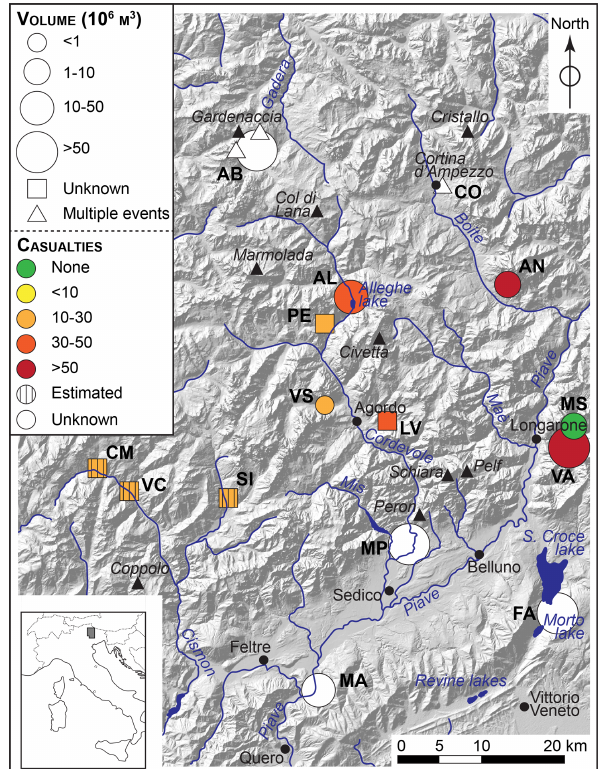
Figure 8. Largest and most damaging (in terms of human lives) landslides located near Mt. Peron (base map is a SRTM- derived digital elevation model with 30m cells; source: http: //viewfinderpanoramas.org/, last access: 17 October 2019). Vol- umes of deposits correspond to the size of the symbols; casu- alties are shown with colour coding. AB: Alta Badia, several events between 11500BCE and present (Borgatti et al., 2004); AL: Alleghe, 1771CE (Ermini and Casagli, 2003); AN: Antelao, 1814CE (Montandon, 1933); CM: Col Mandro, 1825CE (Mon- tandon, 1933); CO: Cortina d’Ampezzo, several events between 10700 and 2000BCE (Borgatti and Soldati, 2010); FA: Fadalto, late glacial to present (Pellegrini and Surian, 1996); LV: La Valle, 1701CE (Montandon, 1933); MA: Marziai, 17500–15000BCE (Pellegrini et al., 2006); MS: Mt. Salta, 1674CE (Montandon, 1933); PE: Pecol, 1841CE (Montandon, 1933); MP: Mt. Peron, late Roman times – early Middle Ages (this work); SI: Siror, 1348CE (Montandon, 1933); VA: Vajont, 1963CE (Borgatti et al., 2004); VC: Val Cia, 1882CE (Montandon, 1933); VS: Valle San Lucano, 1908CE (Aldighieri et al.,